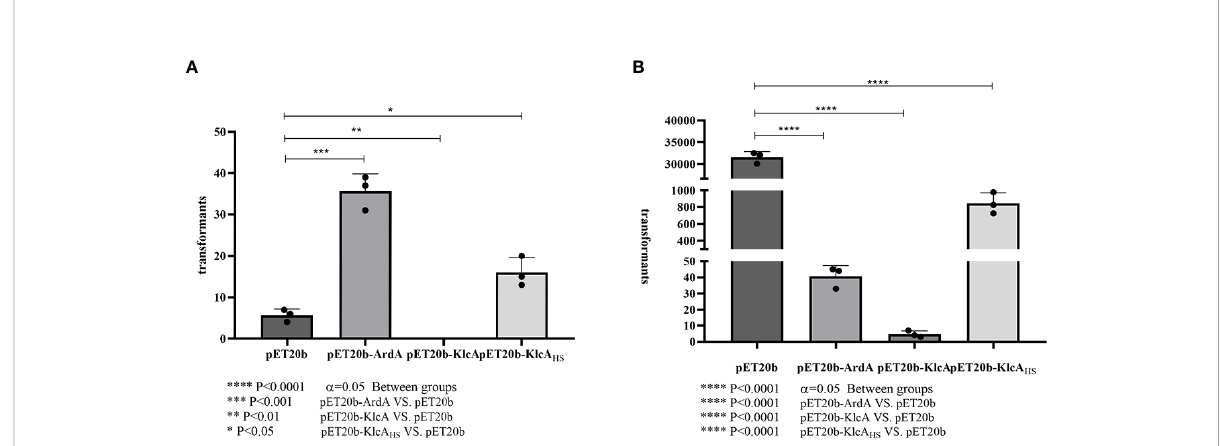
FIGURE 5 Comparison of anti-restriction and anti-methylation activities of three anti-restriction proteins.The X-axis is the three recombinant proteins and the empty vector pET20b, and the Y-axis is the number of transformants. Transformation ef fi ciencies ratios were calculated by dividing the pET20b-ArdA, pET20b-KlcA, pET20b-KlcA HS transformants with the pET20b transformants. (A) : plasmids used were extracted from an R - M - strain. (B) : plasmids used were extracted from E. coli strain (NM1049, EcoKI+). The assay was repeated in triplicate. Data are the means ±